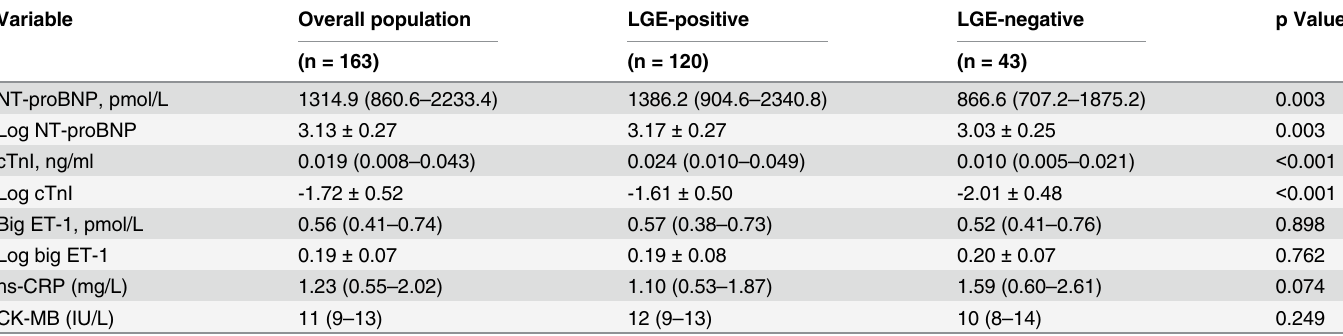
Table 4. Levels of circulating biomarkers in patients with and without LGE * .